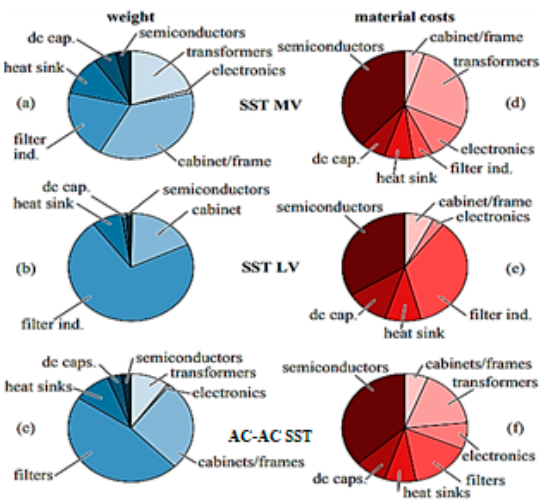
Figure 17. Weight breakdowns of the MV converter ( a ), the LV converter ( b ), and the complete AC–AC SST ( c ); material cost breakdowns of the MV converter ( d ), the LV converter ( e ), and the complete AC–AC SST ( f ) [73]. Reprinted with permission from Ref. [73]. 2022, IEEE.